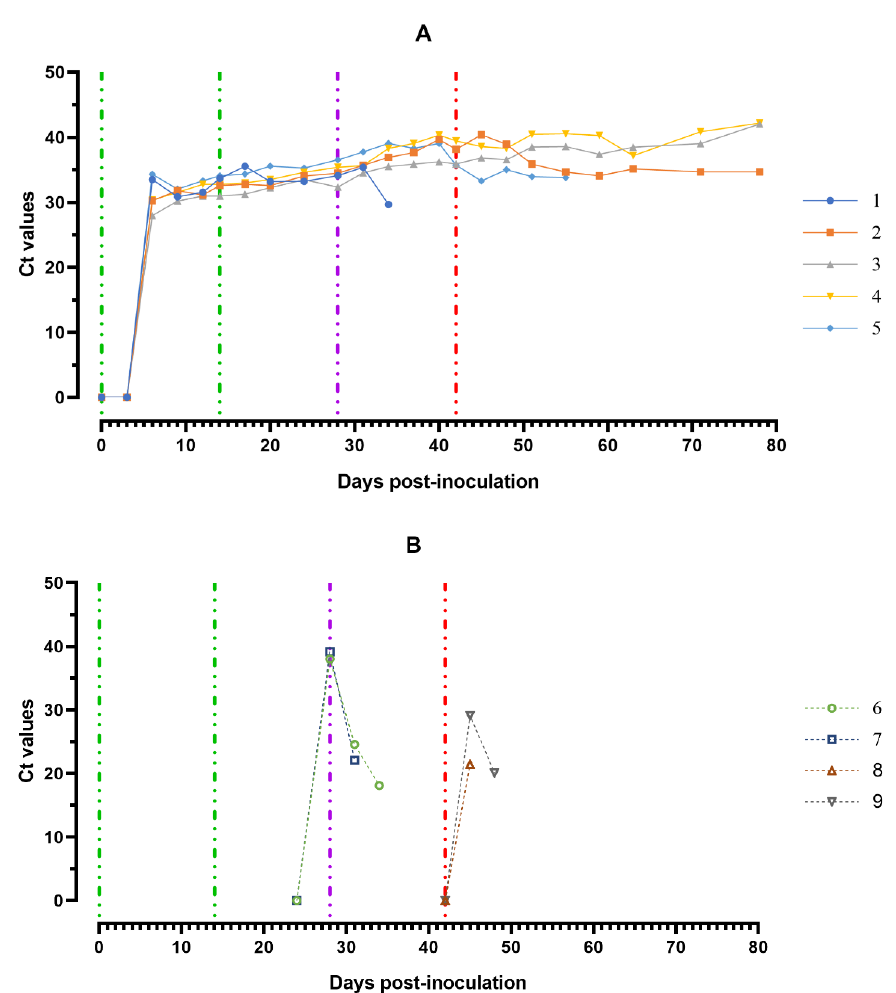
Figure 7. Values of ASFV-specific qPCR results of blood samples of pigs from 0 to 78 dpi: ( A ) group 1 (## 1–5) inoculated with 10 6.0 HAU 50 ASFV-Katanga-350 and challenged at a dose of 10 3.0 HAU 50 ASFV–Lisbon-57 and ASFV–Stavropol 08/01; ( B ) group 2 challenged with ASFV–Lisbon-57 (## 6, 7) and group 3 challenged with ASFV–Stavropol 08/01 (## 8, 9). Each bar represents an individual animal’s values. Vertical dashed lines: green—days of inoculation of ASFV–Katanga-350, purple—challenge by ASFV–Lisbon-57, red—infected by the ASFV–Stavropol 08/01 strain. Results are displayed as Ct.